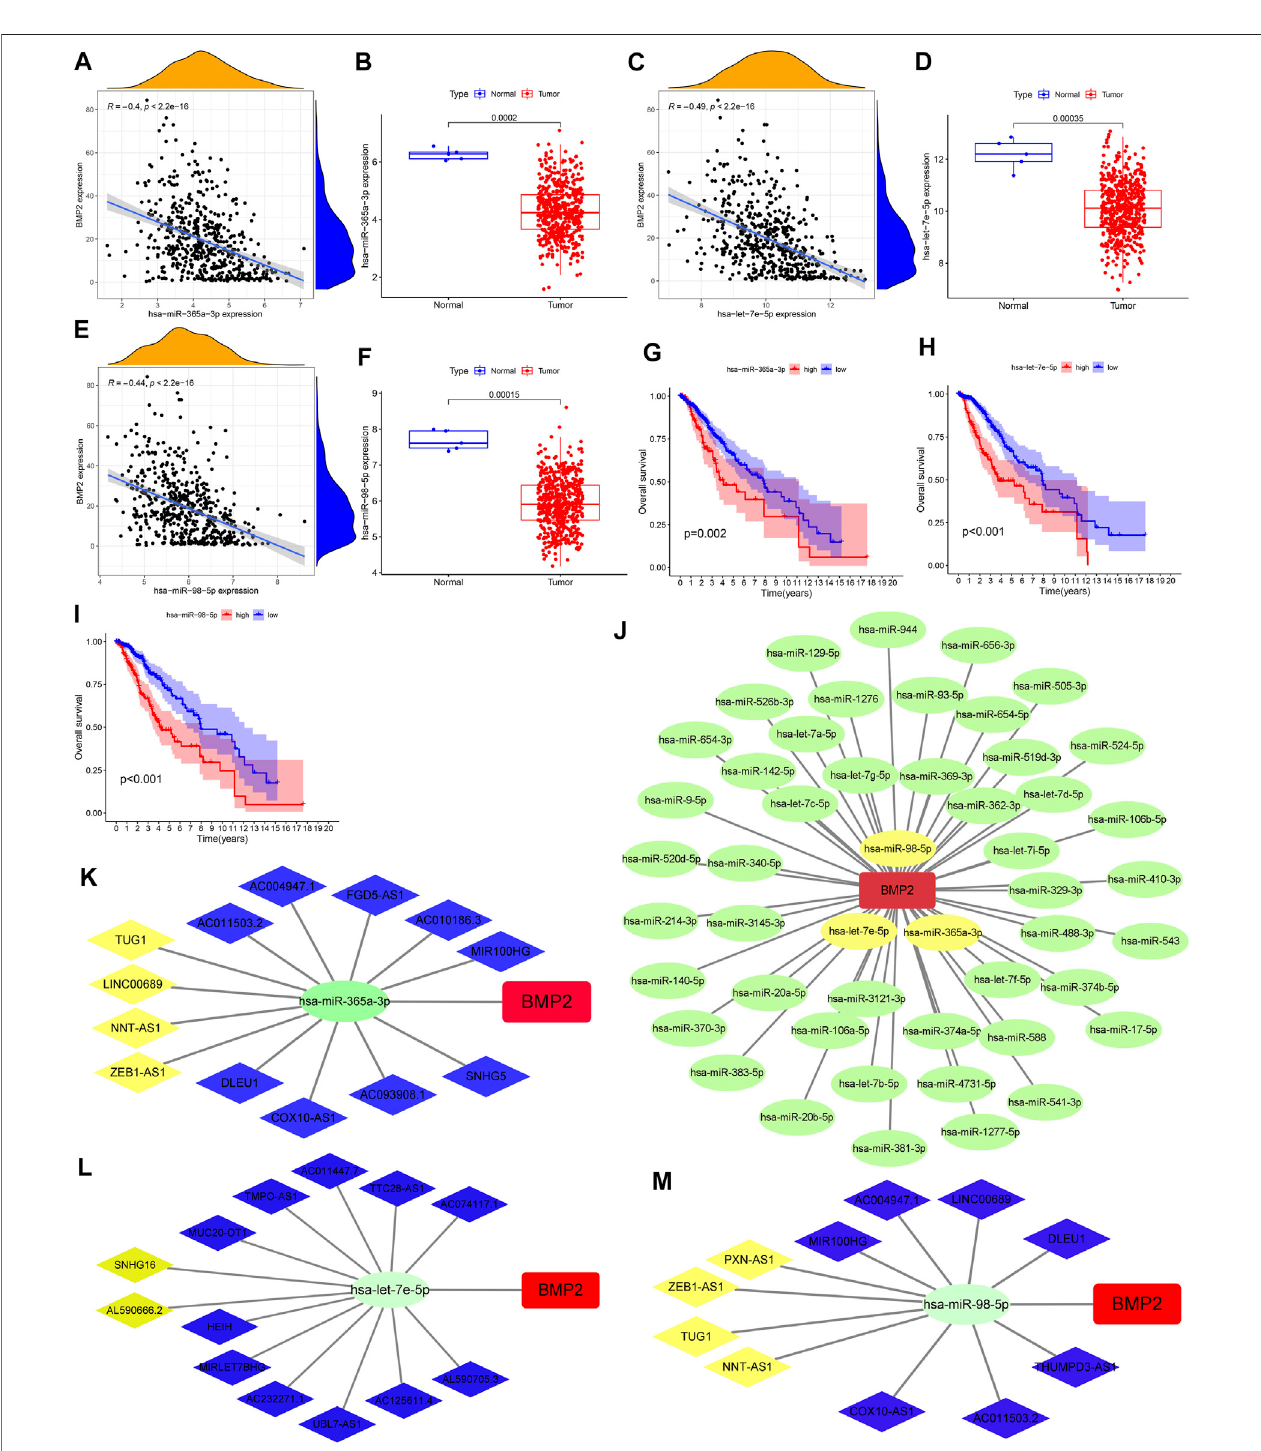
FIGURE10 | Construction ofa comprehensive regulatorynetworkcomposed of interconnected ceRNAs. (A , C , E) Correlationanalysisresults between BMP2 and hsa-miR-365a-3p/hsa-let-7e-5p/hsa-miR-98-5p. (B , D , F) Difference analysis results ofmiR-365a-3p/let-7e-5p/miR-98-5p between the glioma and the normal groups. (G – I) Kaplan-Meier survival curves of hsa-miR-365a-3p/hsa-let-7e-5p/hsa-miR-98-5p. (J) Regulatory network between 52 predicted miRNAs and BMP2. (K – M) CeRNA regulatory networks based on lncRNAs, hsa-miR-365a-3p/hsa-let-7e-5p/hsa-miR-98-5p and BMP2.